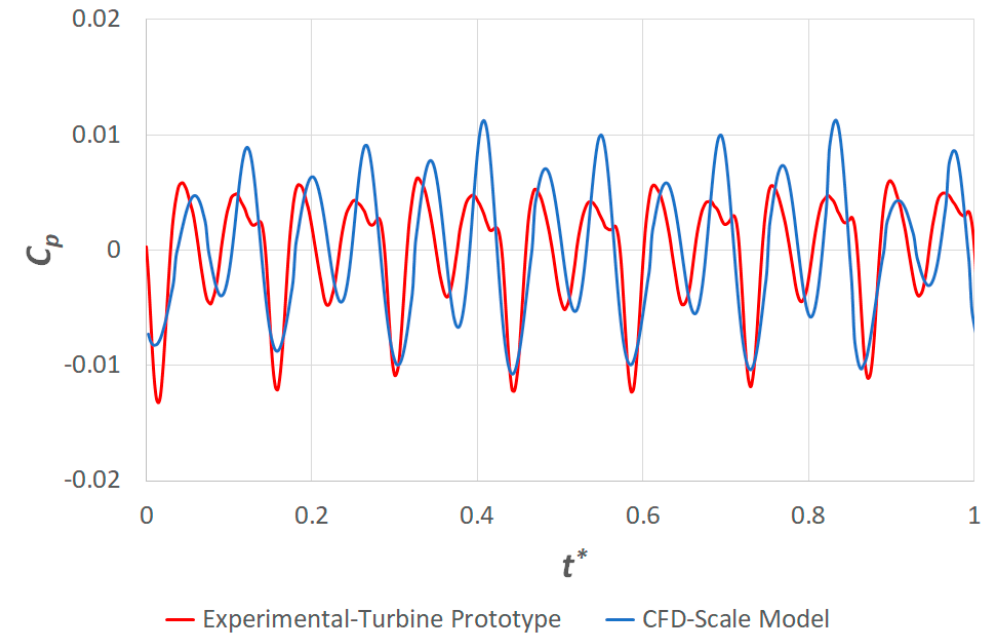
Figure 8. Coefficient of pressure ( C p ) vs. normalized time ( t * ) for pump turbine model (CFD) and prototype (experimental).